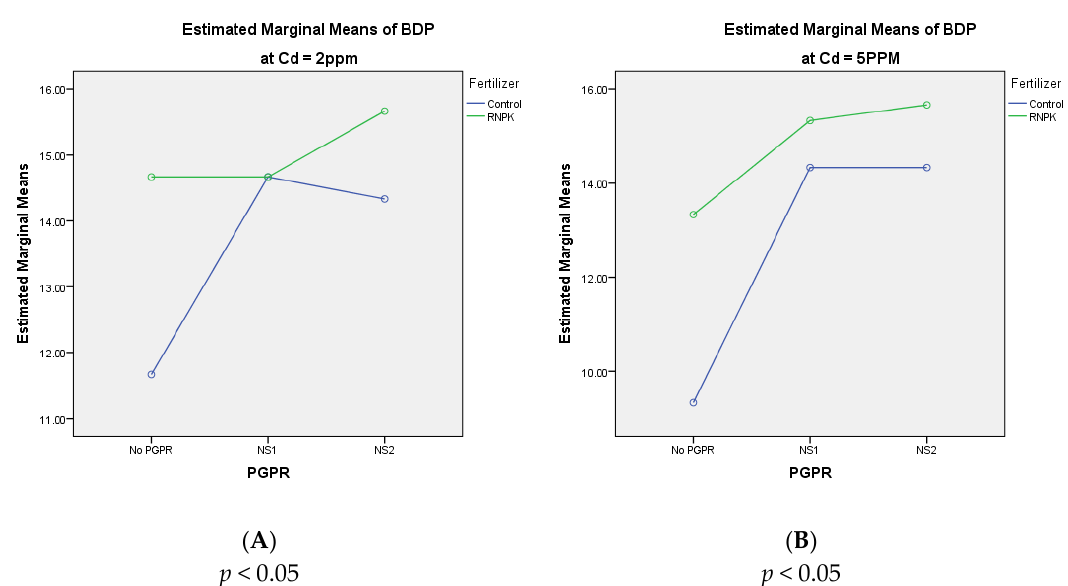
Figure 2. Interaction graph of S. maltophilia (NS1), A. fabrum (NS2), and RNPKF at 2 ( A ) and 5 mg Cd kg − 1 soil ( B ) for number of bitter gourd per plant (BDP).